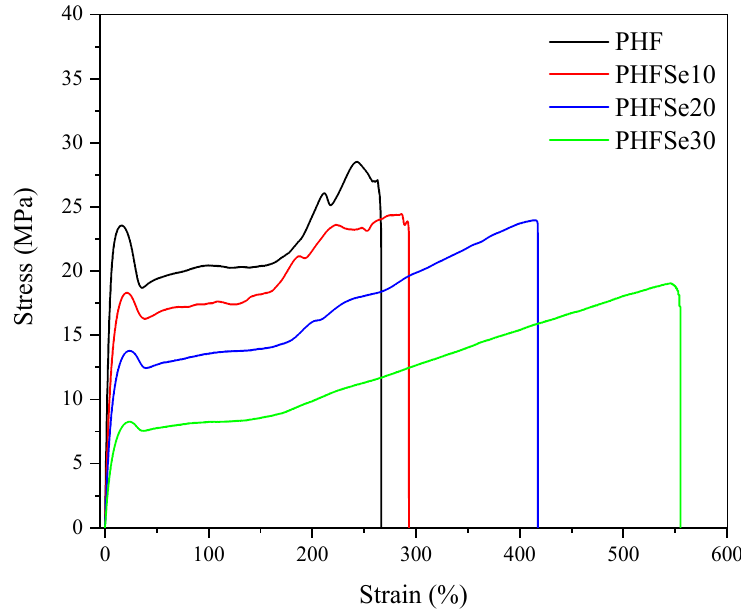
Figure 9. Stress–strain curves of PHF and PHFSe copolyesters. Table 4. Summary of the mechanical property of PHF and PHFDGA copolyesters.